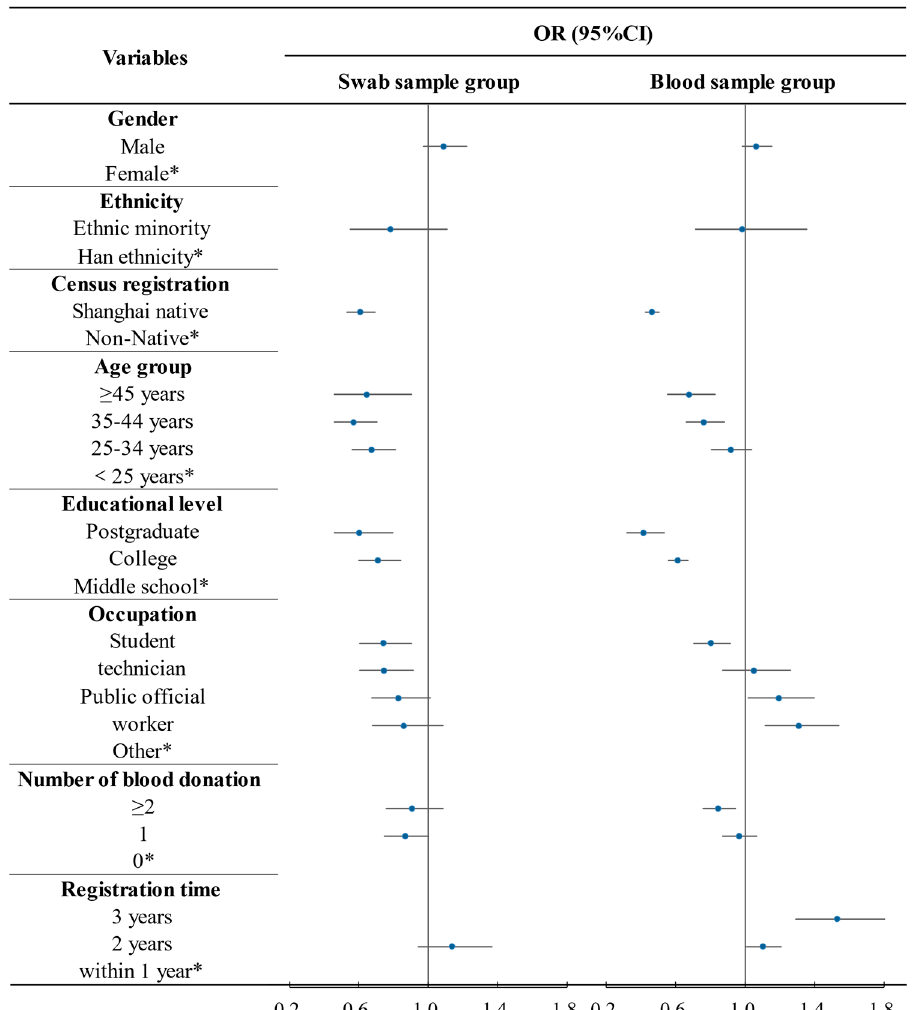
Figure 4. Forest plot of volunteer retention in the swab sample group and blood sample group. OR: odds ratio. CI: confidence interval. The origin in the forest plot represents the OR value, and the horizontal line represents 95% CI. * Indicates a reference.